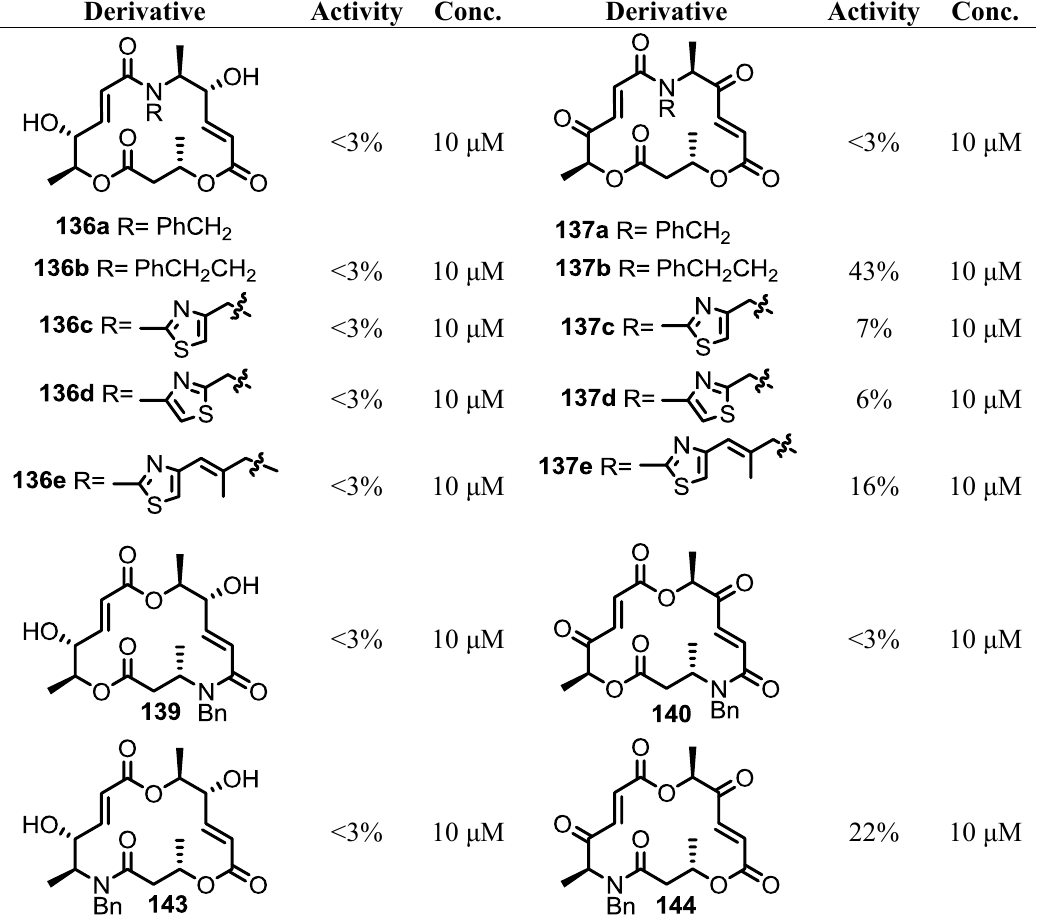
Table 3. Apoptosis Inducing Activity of aza-MS Derivatives Based on DNA Fragmentation a,b .